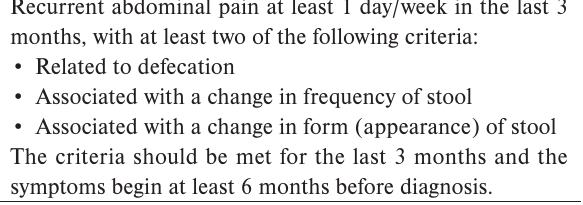
Table 2. Rome IV Criteria for Diagnosing IBS (ref. 51